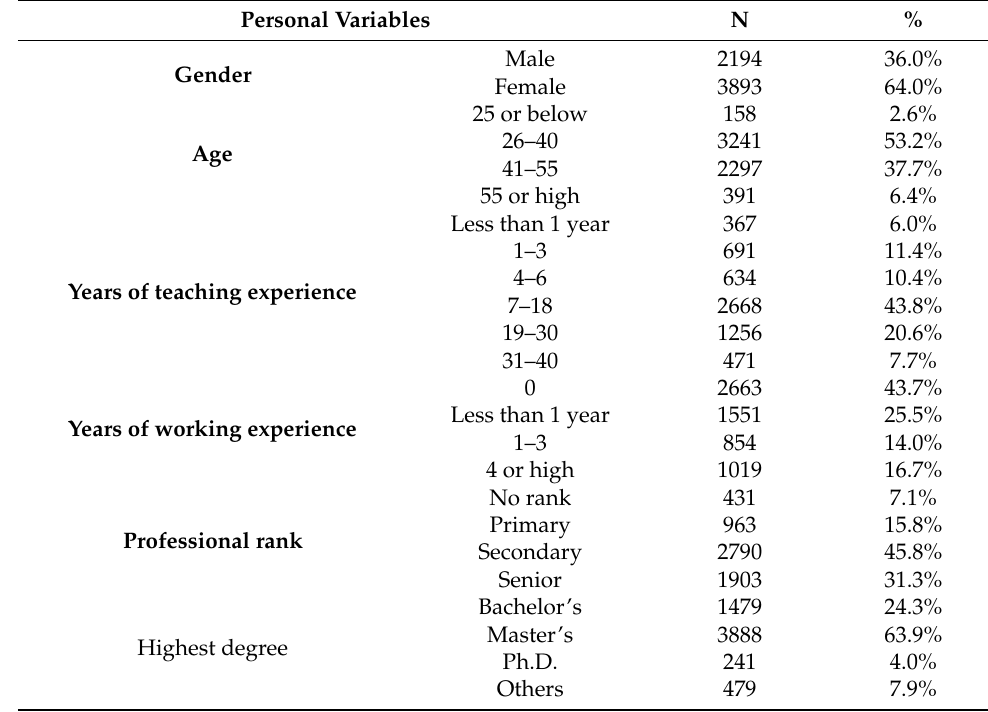
Table 1. Distribution of teachers’ personal variables (N = 6087).